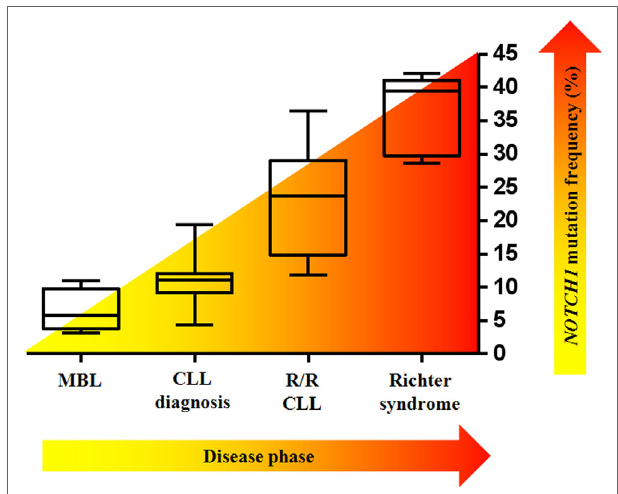
FigURe 4 | NOTCH1 mutation frequency varies according to the clinical time point of the disease. Box–whisker plots indicate the prevalence of mutated NOTCH1 in monoclonal B-cell lymphocytosis (MBL), in chronic lymphocytic leukemia (CLL) at diagnosis, in relapsed/refractory (R/R) CLL, and in Richter syndrome.